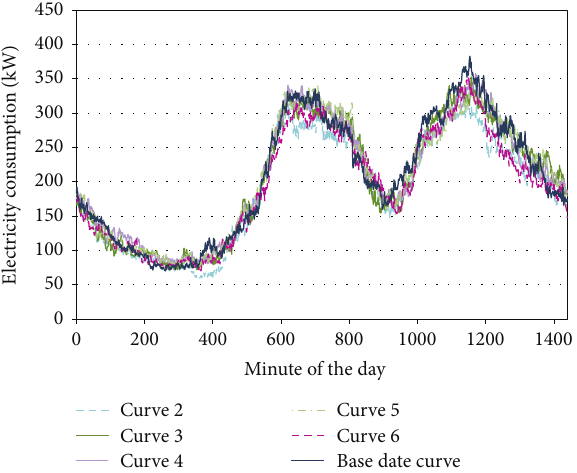
Figure 9: Base date load curve and all curves in cluster correspond- ing to the precrisis